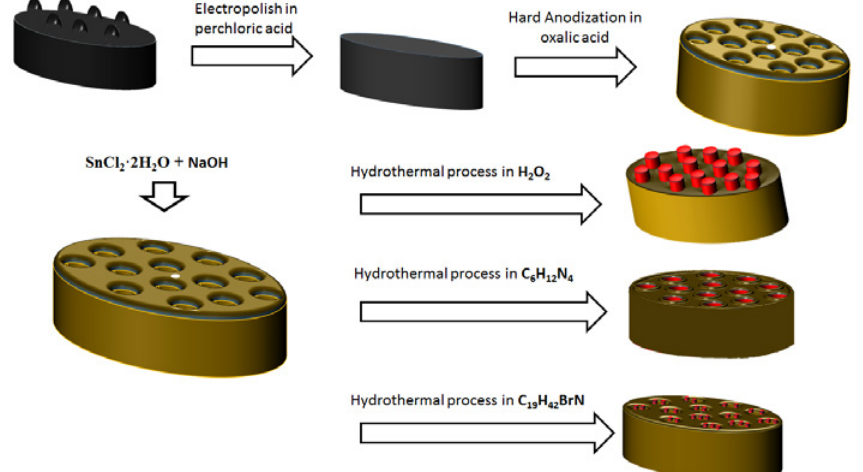
Fig. 2. Schematic of whole synthesis method of tin oxide-alumina